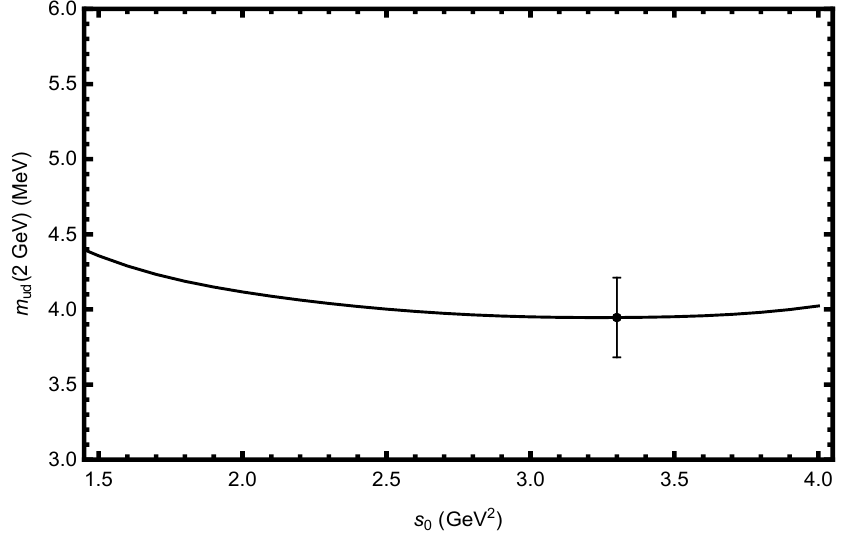
Figure 4 . The quark mass (cid:22) m ud (2 GeV) as a function of s 0 in CIPT from the FESR, eq. (4.9). and the running quark mass entering the FESR is given